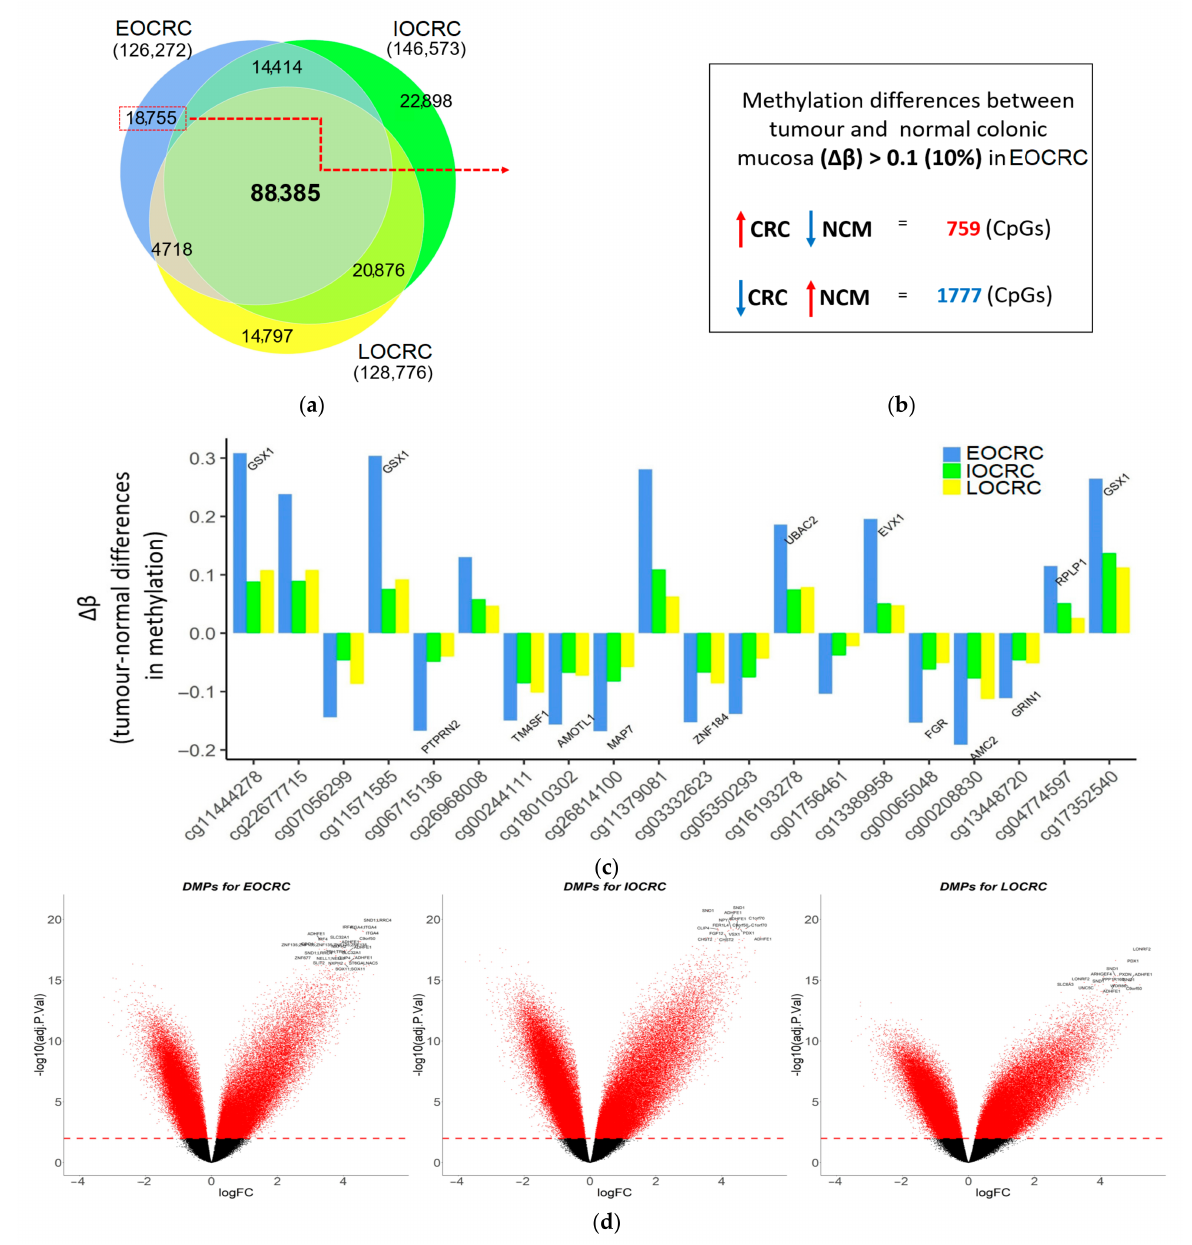
Figure 1. Differential methylation between matched tumour and normal pairs for three age groups. ( a ) (Proportional) Venn diagram showing the numbers of differentially methylated probes (DMPs) between tumour and matched normal mucosa samples for 41 EOCRCs, 34 IOCRCs, and 27 LOCRCs. ( b ) Of 18,755 DMPs with a ∆ β greater than 0.1 that were unique to the tumour-normal pairs from EOCRC, 759 DMPs were hypermethylated, and 1777 DMPs were hypomethylated. ( c ) Barplot illustrating differences in methylation levels ( ∆ β ) between tumour and normal pairs from EOCRC (blue), IOCRC (green), and LOCRC (yellow) for the top 20 DMPs ranked by statistical significance (genes that overlap DMPs are shown). ( d ) Volcano plots illustrating tumour-normal hypo- (<0) and hyper-methylated (>0) DMPs for EOCRC, IOCRC, and LOCRC. Log FC (of M-values) are shown on x -axis, whilst logged adjusted p -values are shown on y -axis. The red line denotes the adj p = 0.01 cut-off, and individual red dots represent statistically significant